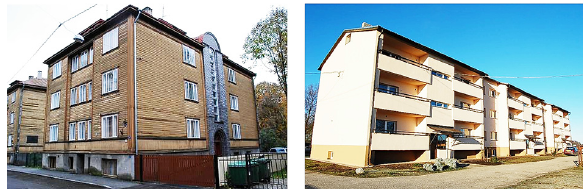
Fig. 2. Typical wooden apartment building (left) and autoclaved aerated concrete large-block building (right)